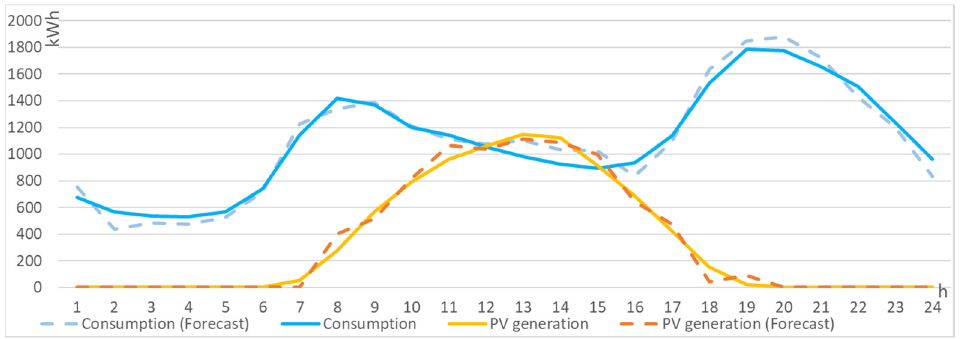
Figure 5. The consumption and photovoltaics (PV) generation, winter sunny day (real and forecasted case).